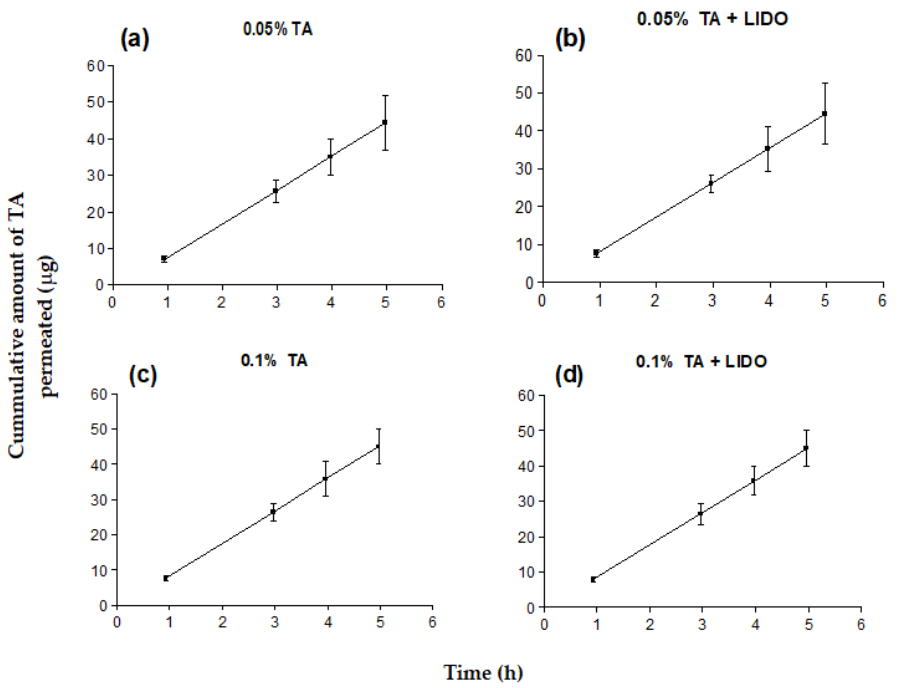
Figure 6. Buccal permeation kinetics of TA for the different formulations. ( a ) 0.05% TA. ( b ) 0.05% TA + LIDO. ( c ) 0.1% TA. ( d ) 0.1% TA +LIDO. Values represent Means ± SD ( n = 5). Table 3. Amount of TA permeated in buccal mucosa per hour (flow). Values represent Means ± SD ( n = 5). No significant differences were observed ( p < 0.05).